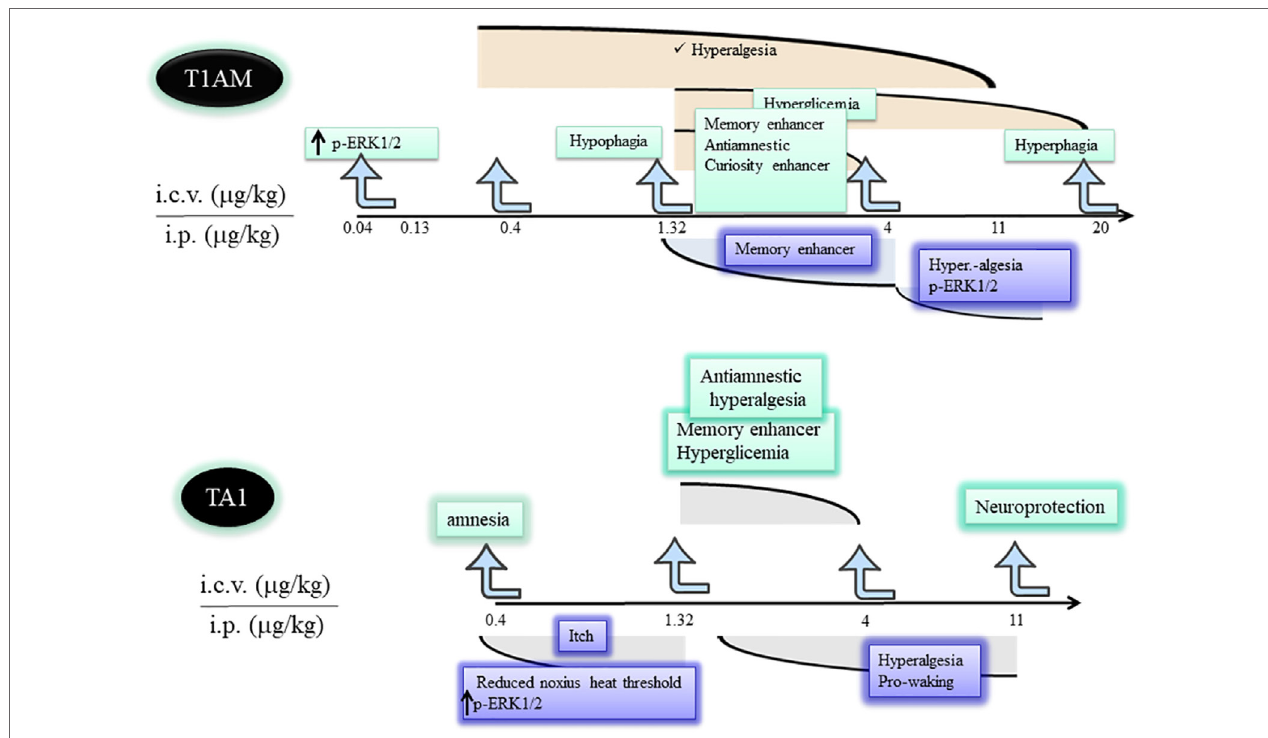
FiGURe 2 | Differences and similarities between T1AM and TA1 pharmacological effects. T1AM and TA1 share pharmacological effects that are described by inverted dose–effect curves. The cartoon indicates similarities and differences among central effects of equimolar doses of T1AM and TA1. Abbreviations: T1AM, 3-iodothyronamine; TA1, 3-iodothyroacetic acid; T0AM, thyronamine; MAO, monoamine